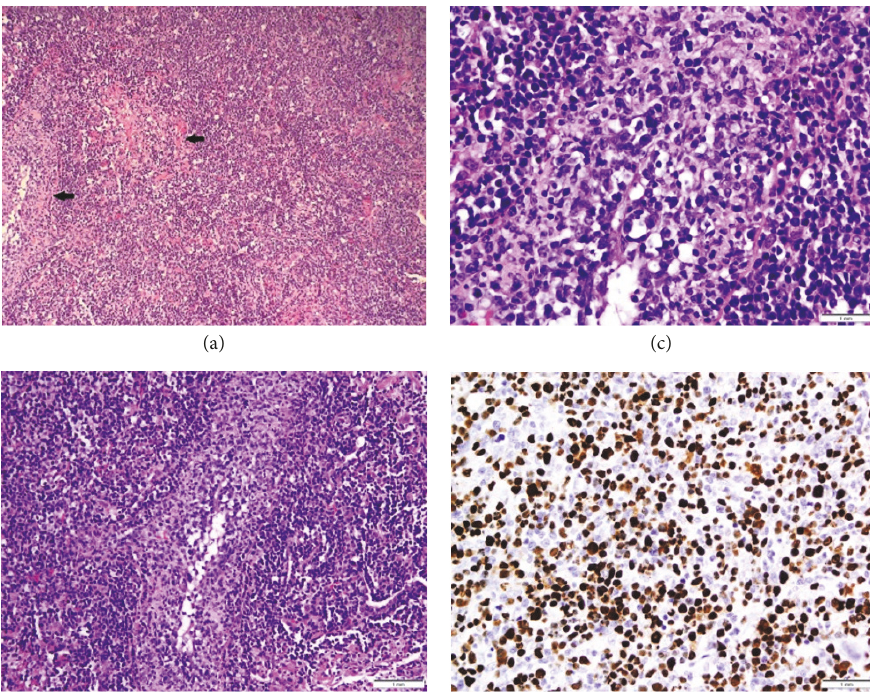
Figure 2: Low power section (a) from lung biopsy showing a diffuse neoplastic lymphoid cells (arrows) infiltrating the lymphatic and bronchovascular bundles. (H&E, 100x) Medium power view (b) showing neoplastic cells involving walls of pulmonary vessels. Small, reactive lymphocytes are seen in the background. (H&E, 200x) High power view (c) shows large, atypical B-cells with irregular nuclear membranes, open chromatin, and prominent nucleoli invading vessel walls (angioinvasion). (H&E, 500x) The neoplastic B-cells were positive for EBV